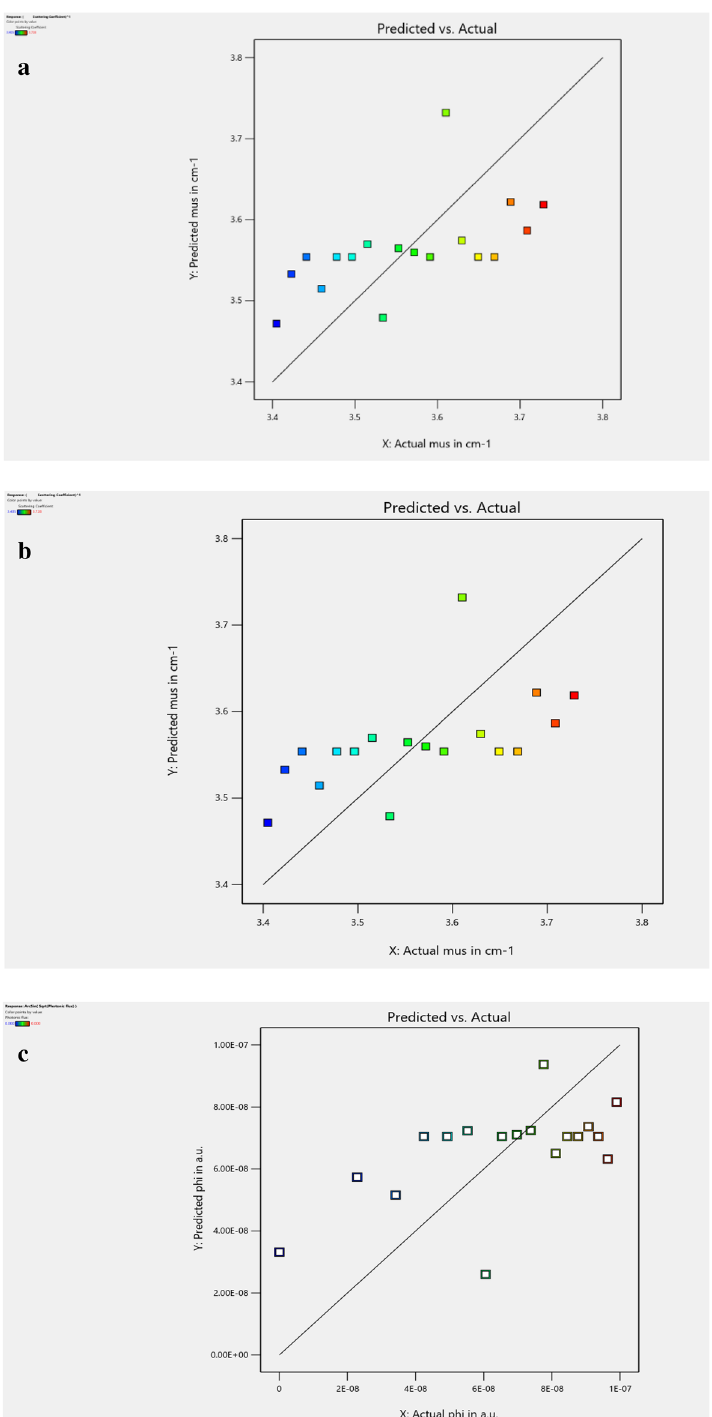
Figure 5. ( a ) Actual versus the Predicted value of mua—checks precise fit of actual response and prediction of mua for a set of values. ( b ) Actual versus the Predicted value of mus—checks precise fit of actual response and prediction of mus for a set of values. ( c ) Actual versus the predicted value of phi—checks precise fit of actual response and prediction of phi for a set of